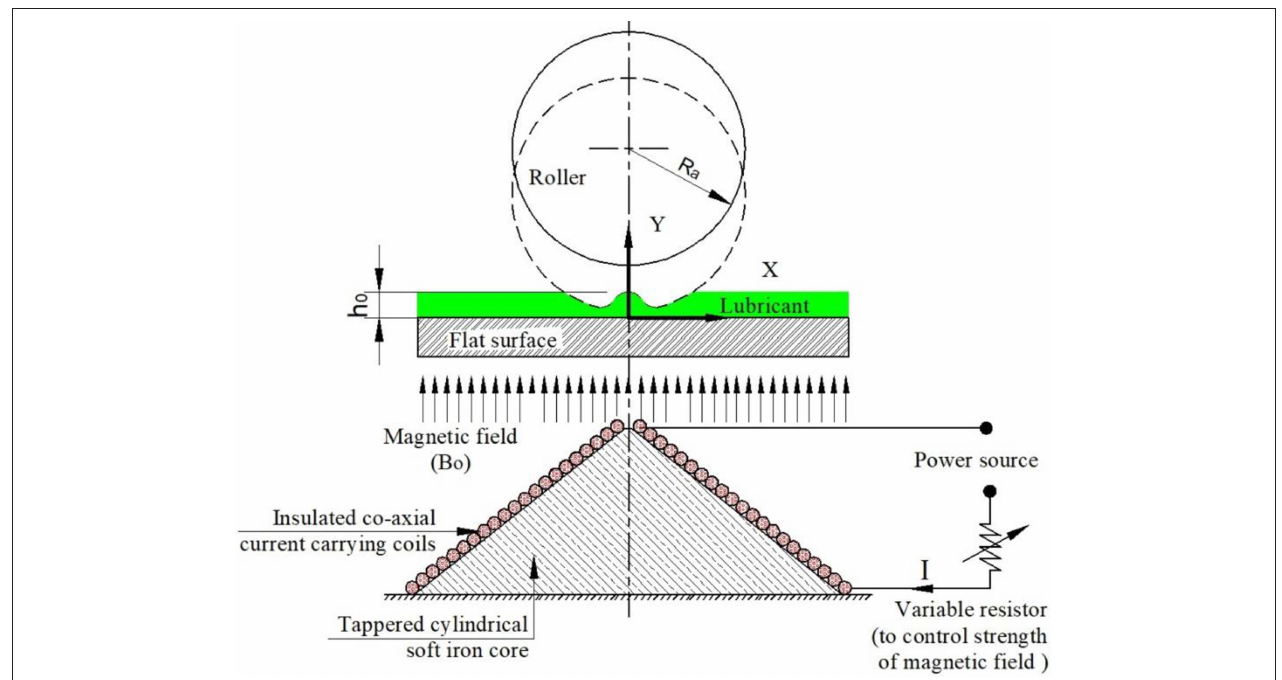
FIGURE 1 | EHL line conjunction under the influence of external magnetic field.